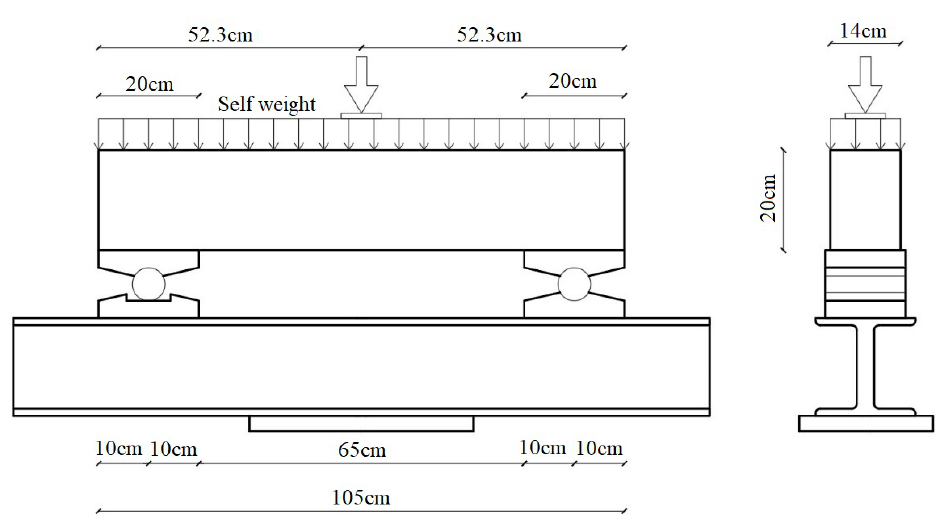
Figure 1. Diagram of the loads of the